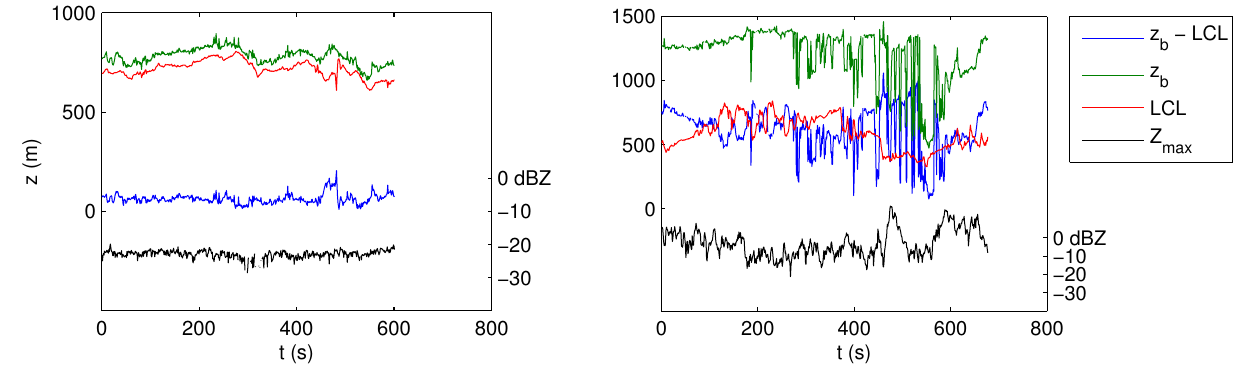
Fig. 5. Cloud base and LCL of the subcloud legs adjacent to the profiles shown in Fig. 2, showing an example of the mesoscale structure associated with a well-mixed (left) and decoupled (right) boundary